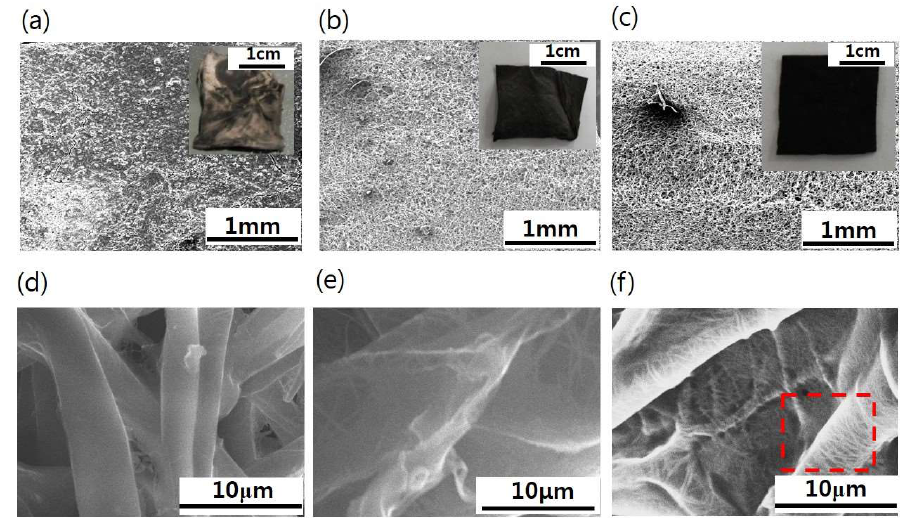
Figure 2. Field-emission scanning electron micrographs (FESEM) of the SWCNT/SBS nanofiber mats following different surface treatments: ( a , d ) UVO treatment; ( b , e ) Polydopamine treatment; ( c , f ) Zonyl treatment. The insets in ( a – c ) show photographs of the SWCNT/SBS nanofiber mats. The red dotted box in ( f ) clearly shows the densely coated SWCNT on SBS nanofiber.